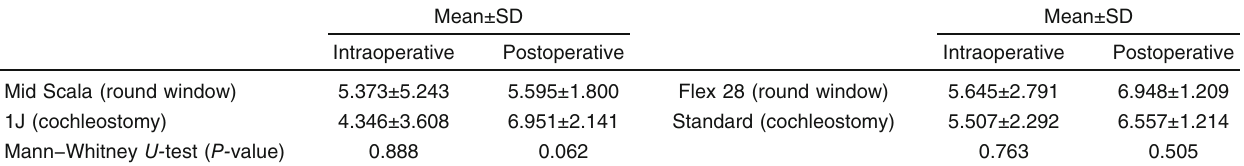
Table 2 Comparison between intraoperative and postoperative mean±SD of each two electrodes (Mid Scala, 1J, Flex 28, and